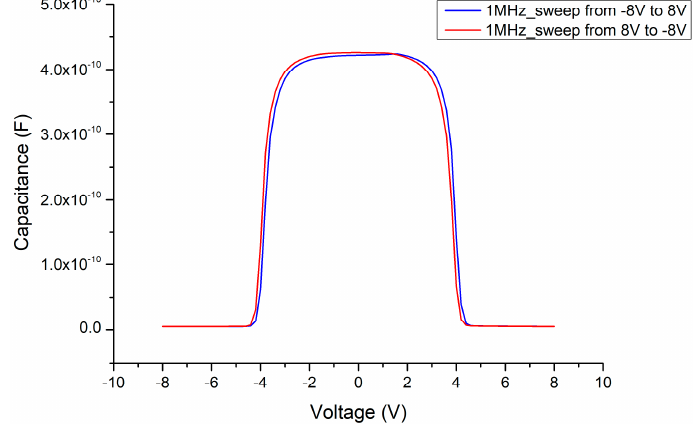
Figure 14. C–V measurement comparison of the MSM varactor between ± 8 V.